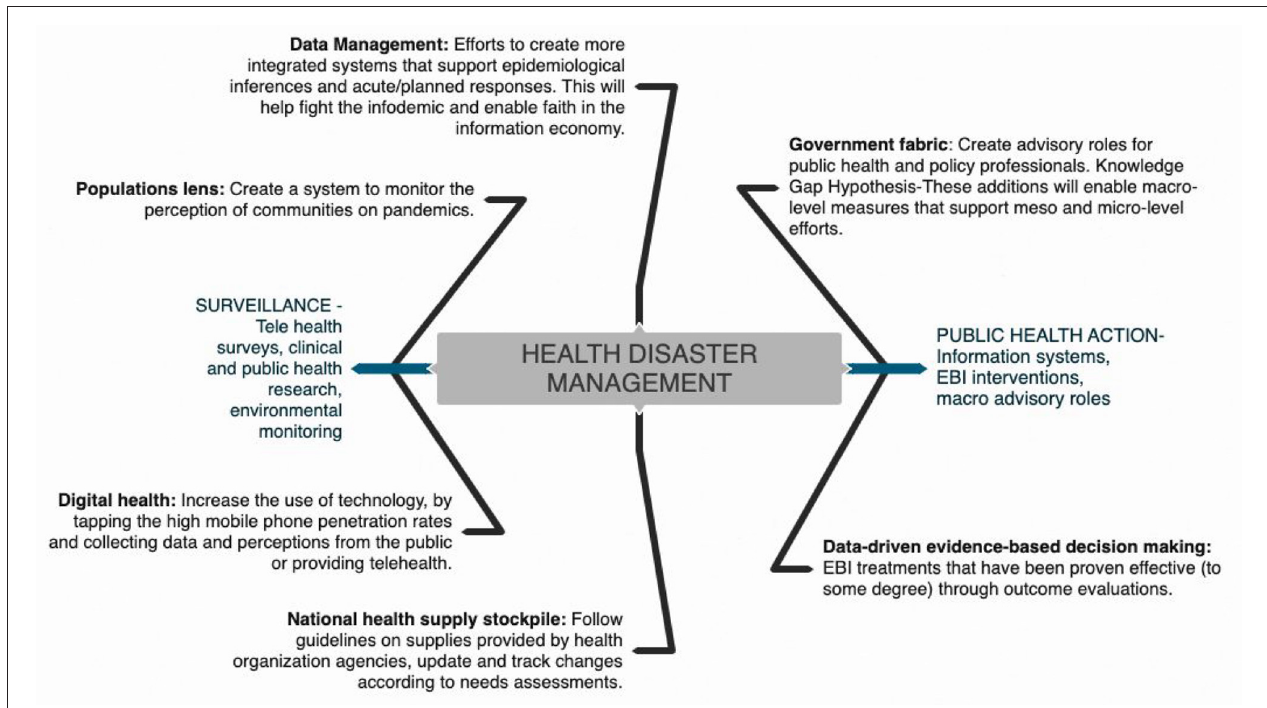
FIGURE 9 | Framework to support decision making for future pandemic preparedness.